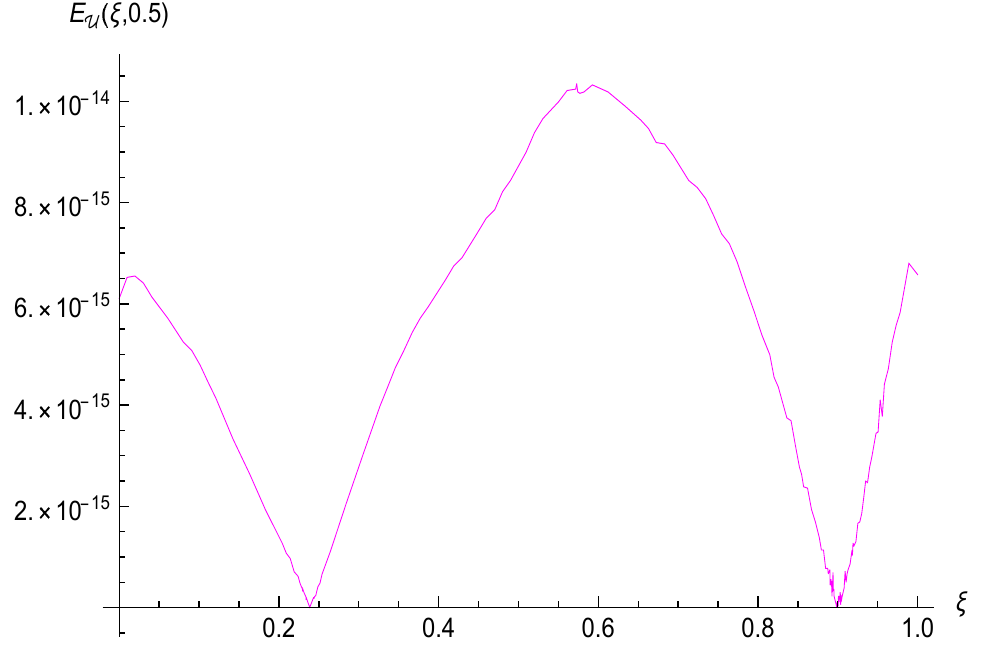
Figure 15. ξ -Absolute errors graph E U ( ξ ,0.5 ) of the problem (33), where σ 1 = (cid:36) 1 = σ 2 = (cid:36) 2 = 0, ν = 0.9 and N = M = 16.